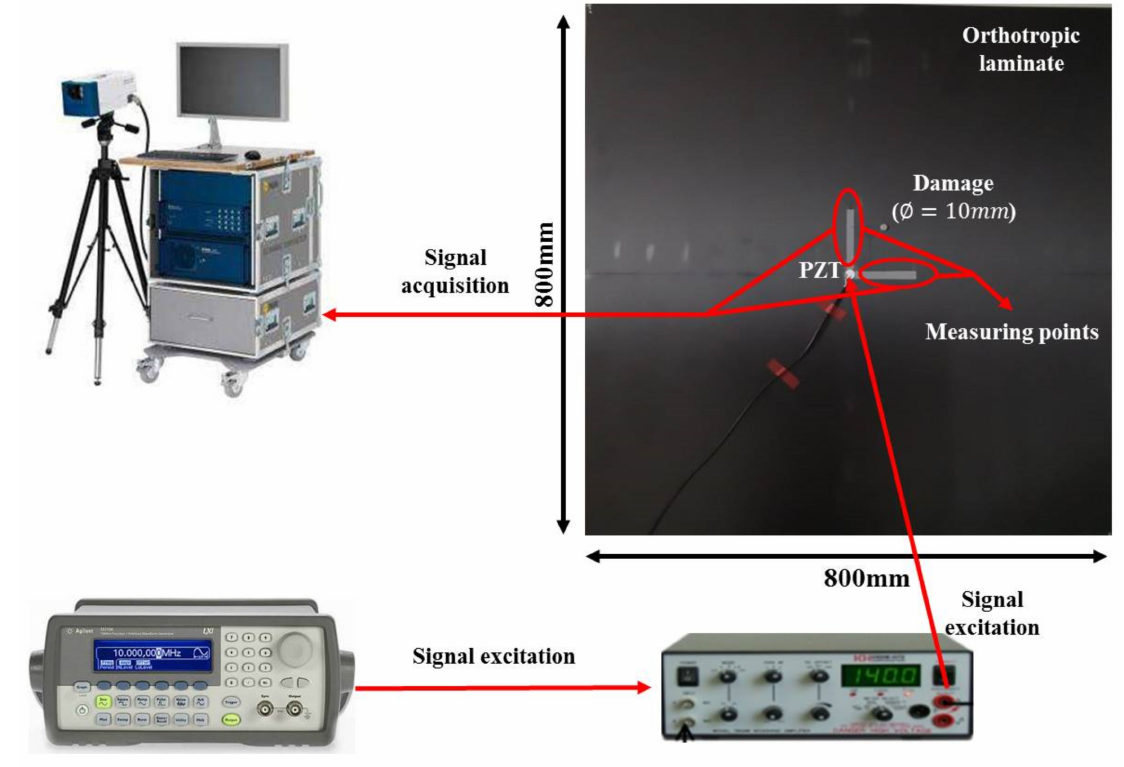
Figure 9. Schematic diagram of the experimental setup.